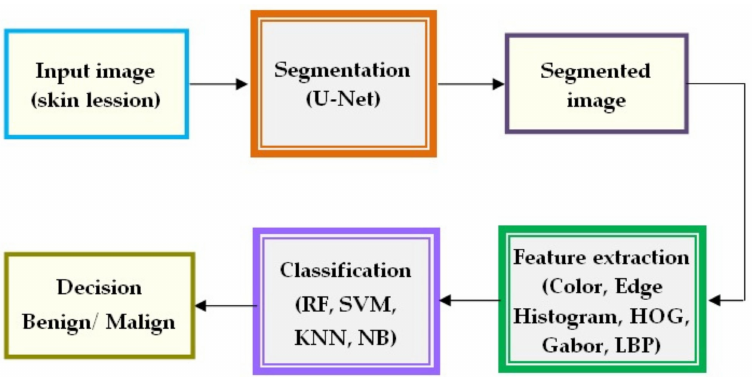
Figure 29. The schematic architecture of the skin lesion classification system based on CNN for the segmentation, feature extraction, and intelligent classification